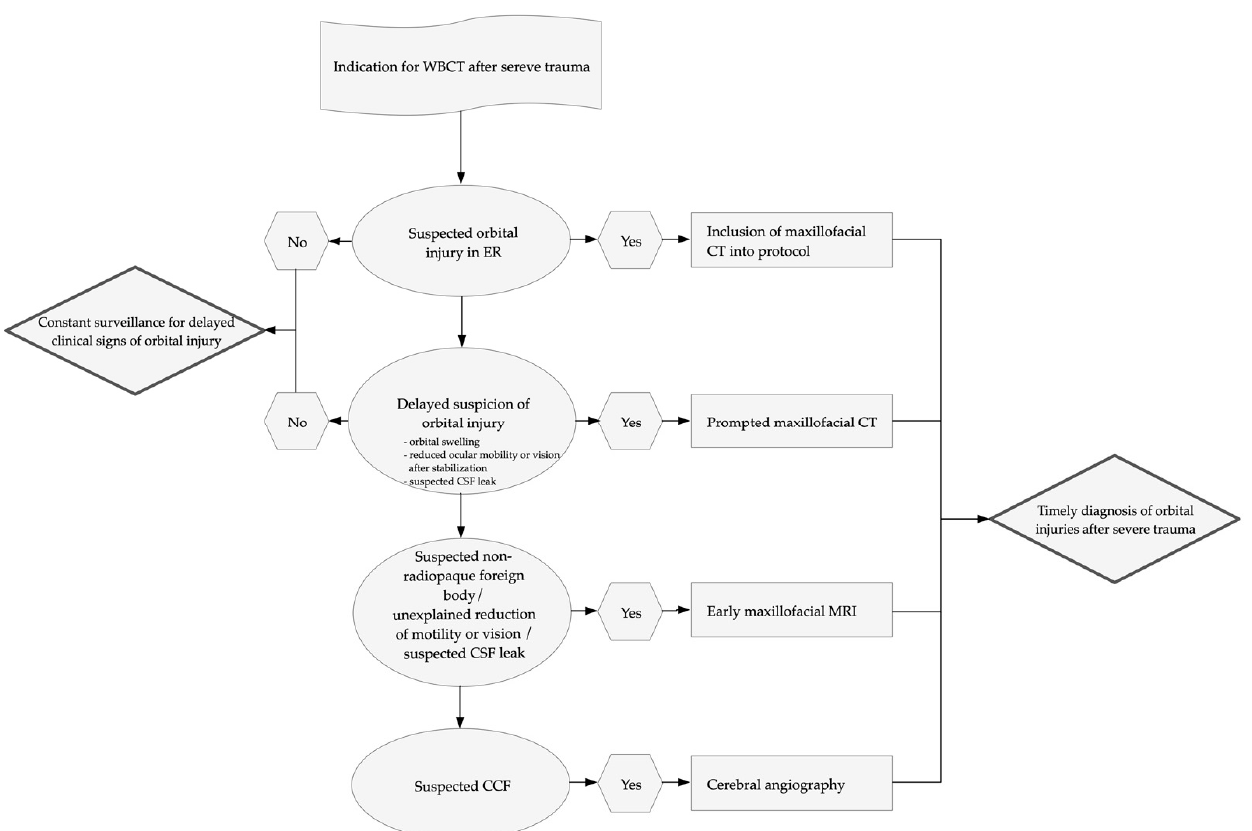
Figure 8. Exemplary protocol for diagnosis and treatment of orbital injuries. The figure highlights the importance of thorough initial clinical and radiological examinations and of an ongoing surveillance for delayed clinical sings of orbital injuries to allow for prompt or early imaging via CT, MRI, or cerebral angiography in the acute and subacute phase after severe trauma (WBCT = whole-body CT, CSF = cerebrospinal fluid, CCF = carotid-cavernous fistula).